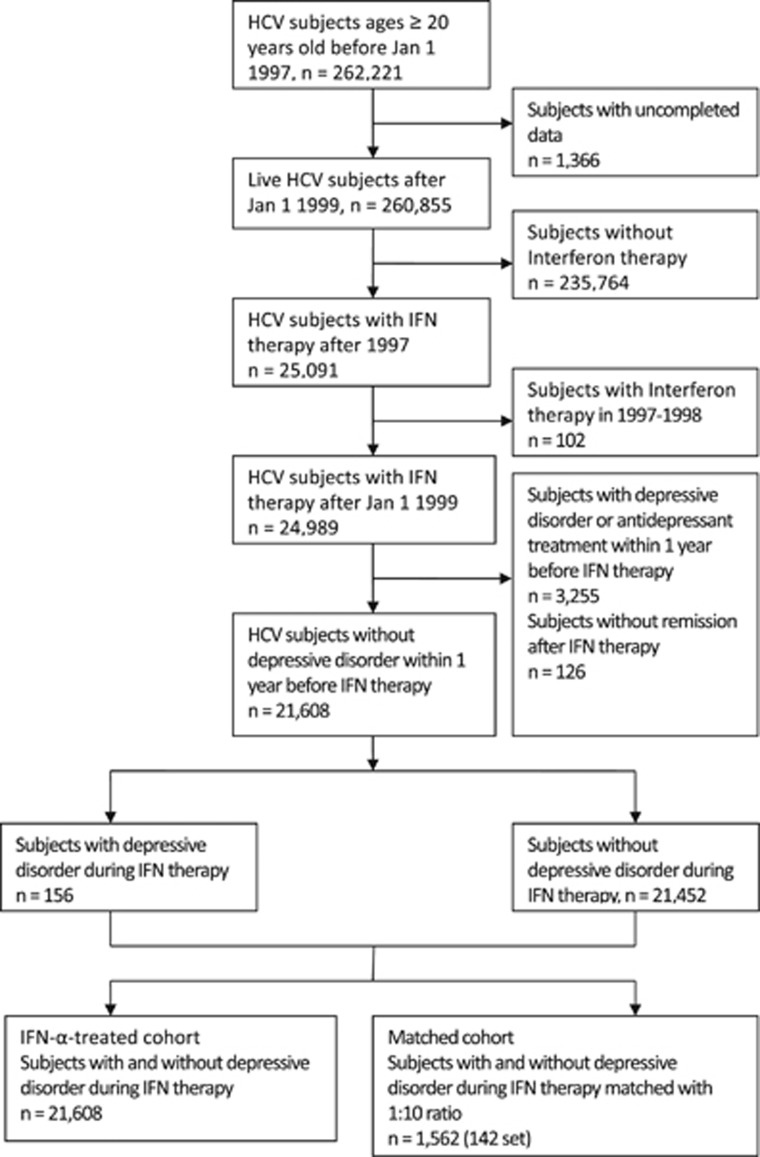
Flow of the Study Subjects Enrollment. We conducted a population-based cohort study from the Longitudinal Health Insurance Database of Taiwan, in which all patients older than 20 years who had a first-time diagnosis of hepatitis C virus (HCV) infection (International Classification of Diseases, Ninth Revision (ICD-9) codes 070.7, 070.41, 070.44, 070.51, 070.54 and V02.62) and received interferon (IFN) therapy between 1 January 1997 and 31 December 2010 formed the study cohort. The IFN-α-induced depression cohort comprised people who had the diagnosis of depressive disorder (ICD-9 codes 296.2, 296.3, 300.4 and 311) during the period between IFN-α therapy and the 30th day after the last IFN-α therapy. Patients with previous histories of depression diagnosis and antidepressant therapy before 1 year of IFN-α therapy were excluded when enrolling both cohorts. To ensure the remission of IFN-α-induced depression, the patients should have at least 6 months of free interval (without any diagnosis of depressive disorders or receiving any antidepressant therapy) after IFN-α induced depression. (Right bottom box) IFN-α-treated cohort: (n=21 608). (Left bottom box) Matched cohort: matching was performed on the characteristics of sex, age, history of depression with 1:10 ratio of the IFN-α-induced depression and without IFN-α-induced depression (n=1562 (142 pairs)).